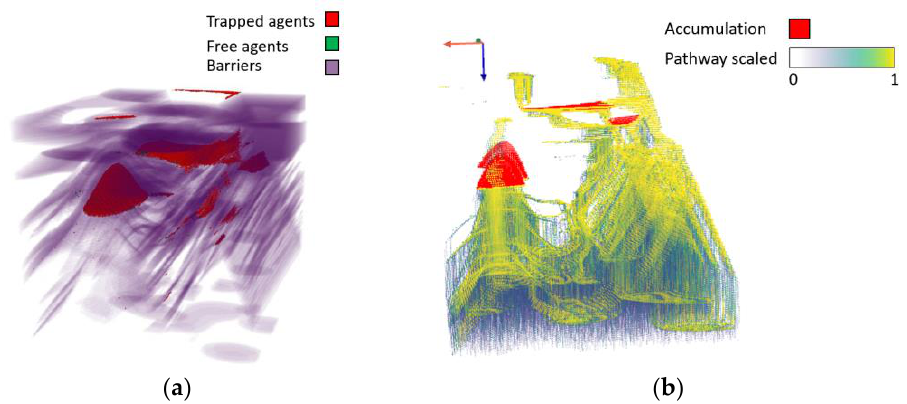
Figure 4. Spatial visualisation of exemplary 3D simulation results. ( a ) Agents’ final positions and flow barriers; ( b ) pathways (scaled between 0 and 1) of the agents where high values are associated with more agents passing in the cell and vice versa. Accumulations are highlighted in red.